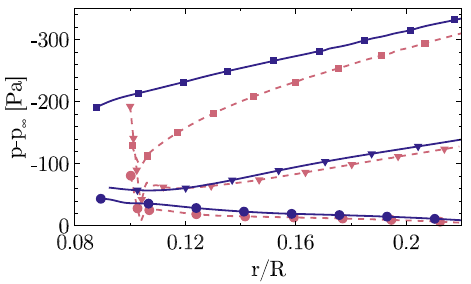
Figure 10. The effect of the nacelle on radial pressure distribution on the suction side at x c /c ≈ 0 . 1 (squares), x c /c ≈ 0 . 5 (triangles) and x c /c ≈ 0 . 85 (circles) for CaseIsoRotor (dashed), CaseT1.0